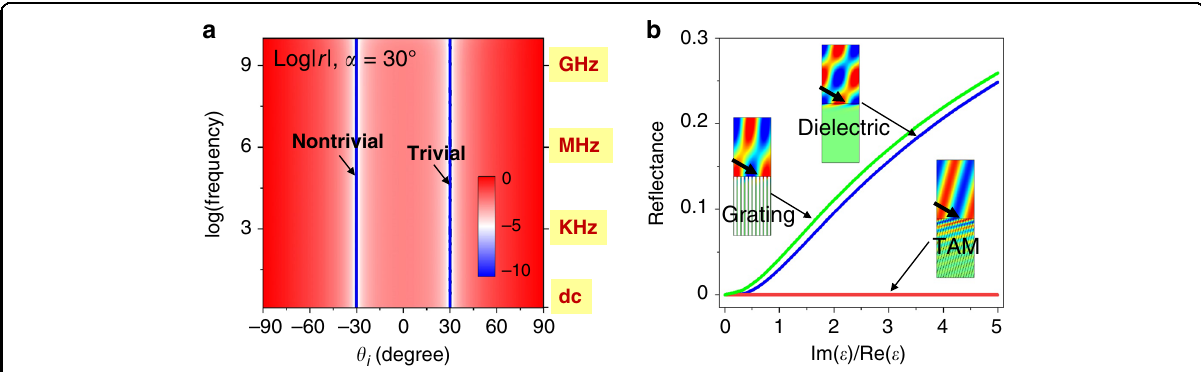
Fig. 5 The ultra-broad bandwidth of ABE and the dependence of re fl ection on absorption. a Re fl ection coef fi cient as the function of the θ i at the interface of free space and the effective medium model of the CF array in Fig. 4. The nontrivial solution corresponds to the ABE that enables fl exible large absorption and tunable angle of refraction, while the trivial solution is similar to the traditional Brewster effect, without absorption and tunable refraction. b Re fl ectance as the function of material loss at the interfaces of air-dielectric (blue lines), air-PEC-grating (green lines), and air-TAM (red lines) under θ i ¼ 75 (cid:2) . The TAM is composed of subwavelength tilted CF array in a dielectric host with ε d ¼ tan 2 75 (cid:2) and α ¼ (cid:3) 15 (cid:2) . Re ε ð Þ and Im ε ð Þ denote the real and imaginary parts of the permittivity of the dielectric, or the fi lling material in grating slits, or the CF of the TAM, respectively. The insets show the simulated magnetic- fi eld distributions when Im ε ð Þ = Re ε ð Þ ¼ 5 for the dielectric and grating models, Im ε ð Þ = Re ε ð Þ ¼ 500 for the TAM